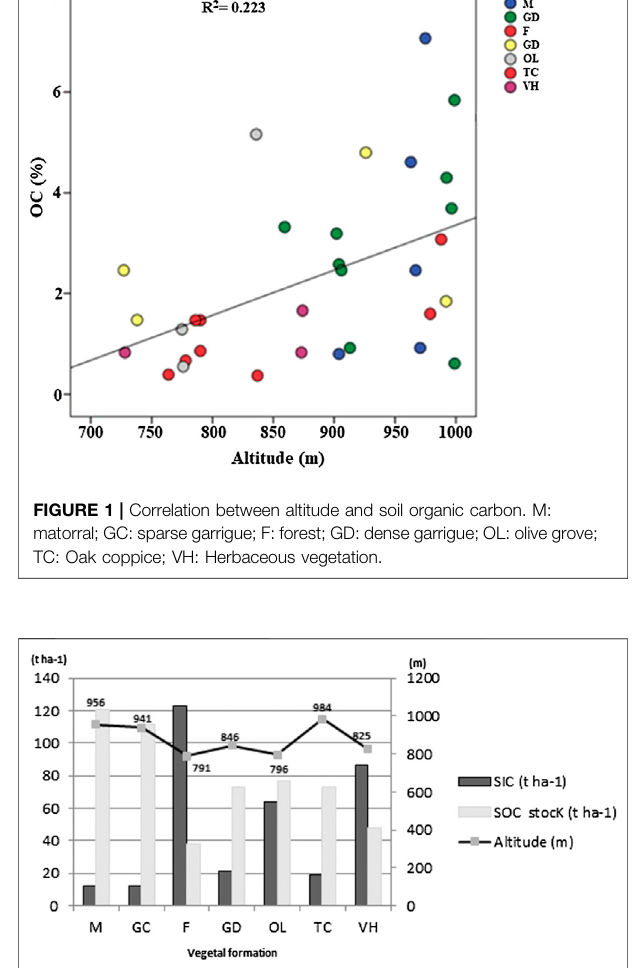
FIGURE 2 | SOC stocks variation according to SIC (CaCO3) and altitude. M: matorral; GC: sparse garrigue; F: forest; GD: dense garrigue; OL: olive grove; TC: oak coppice; VH: herbaceous